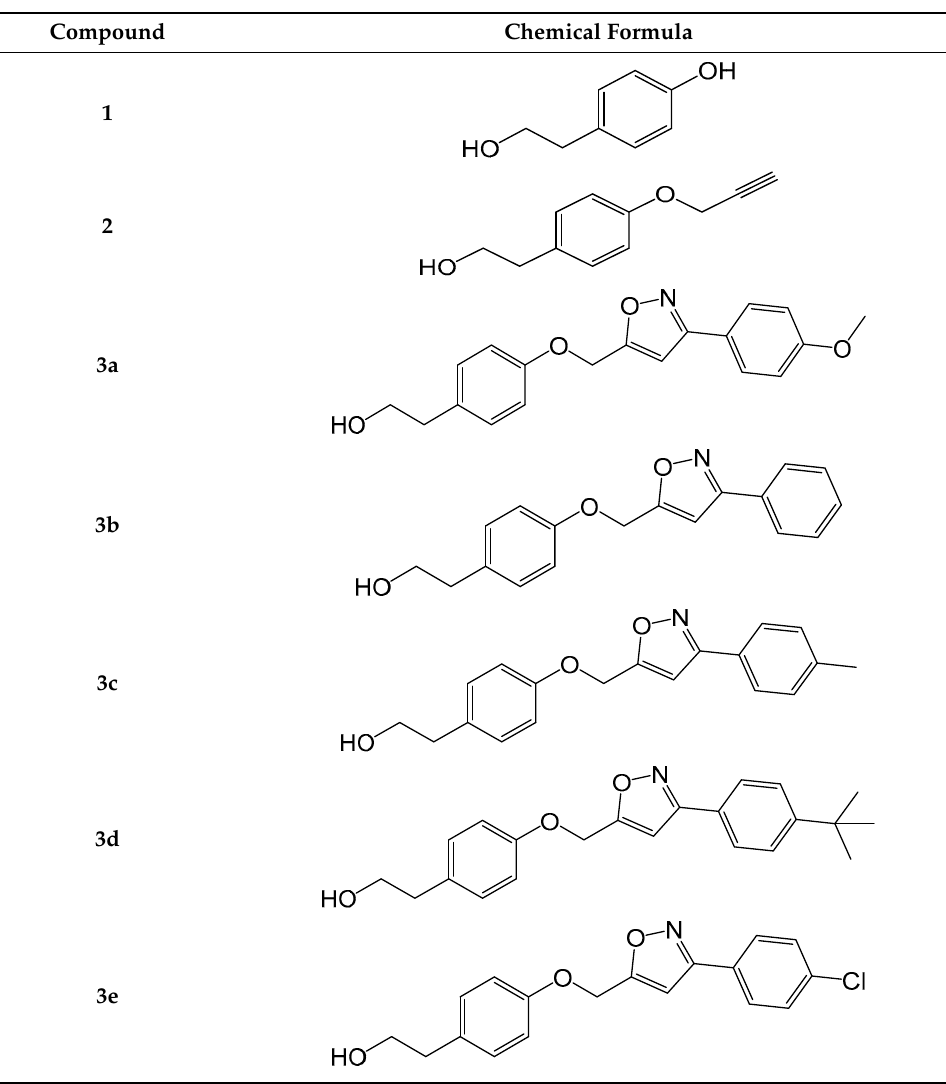
Table 2. Structures of tyrosol ( 1 ), tyrosol-alkyne ( 2 ), tyrosol-linked 3,5-disubstituted isoxazoles ( 3a – e )